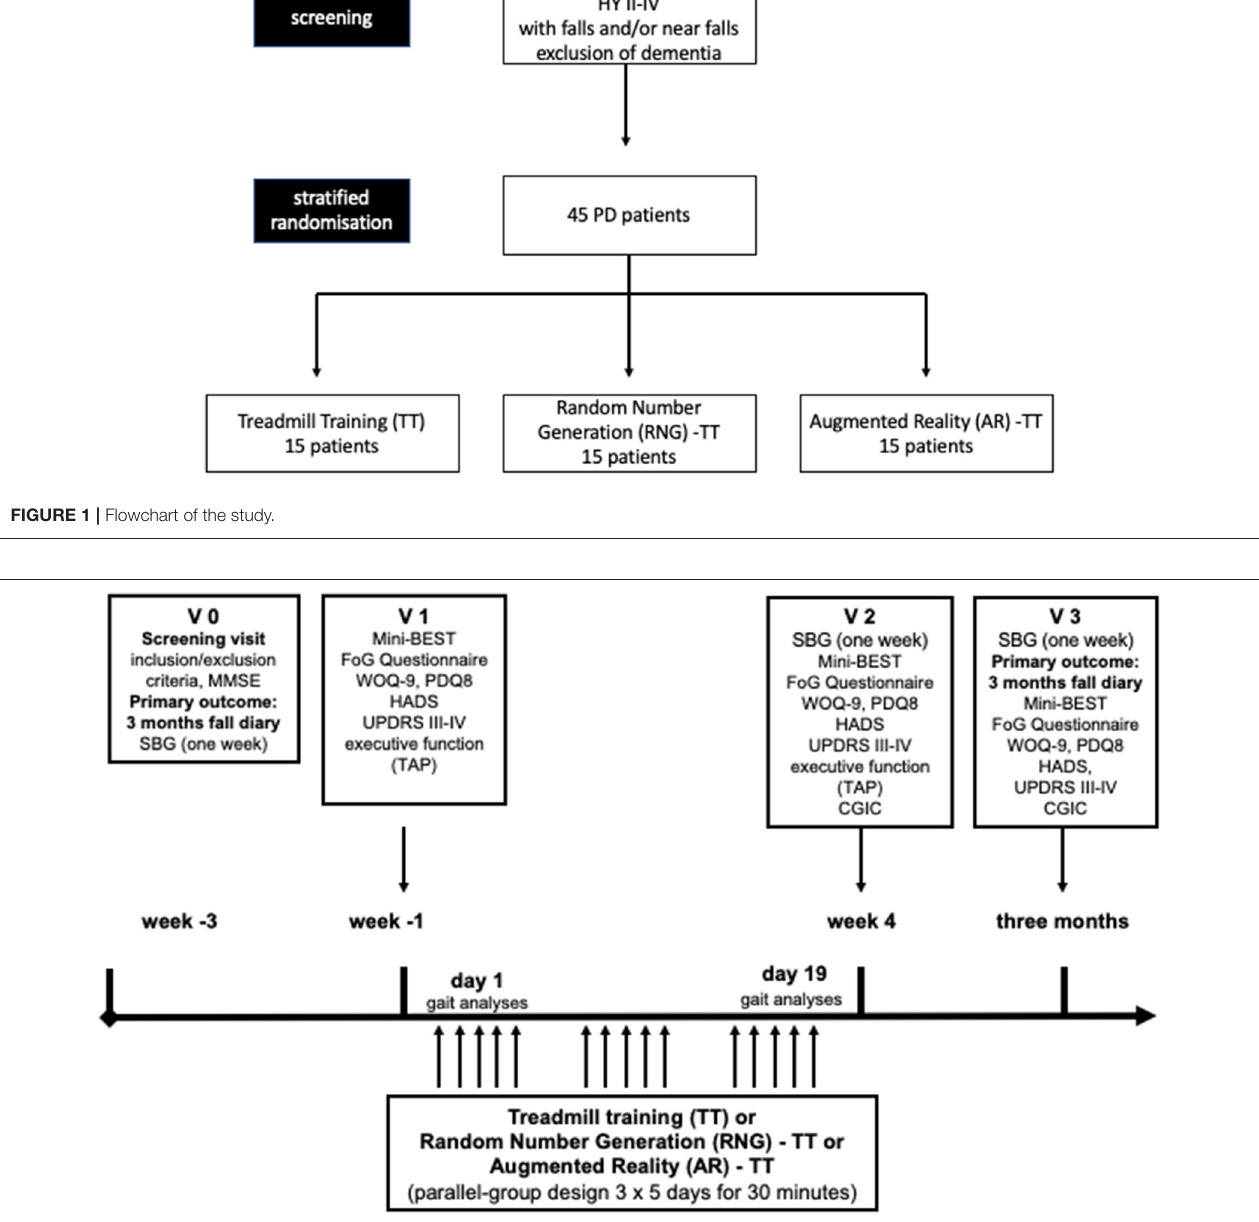
FIGURE 2 | Experimental protocol design. MMSE, Mini-Mental Status Examination; Mini-BEST, Mini-Balance Evaluation Systems Test; SBG, sensor-based gait analyses; FoG, freezing of gait; WOQ-9, Wearing-Off Questionnaire-9; PDQ8, QoL in PD questionnaire; HADS, Hospital Anxiety and Depression Questionnaire; MDS-UPDRS, MDS-sponsored revision of the Unified Parkinson’s Disease Rating Scale; CGIC, Clinical Global Impression of Change; TAP, Test Battery of Attentional